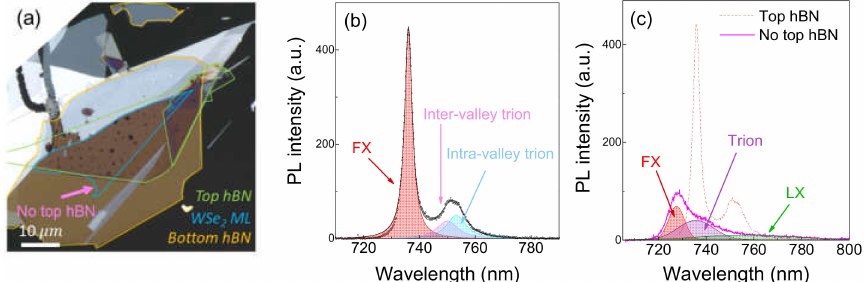
Figure 1. ( a ) Optical microscope image of the WSe 2 monolayer encapsulated by hBN. ( b ) Photoluminescence spectrum of the WSe 2 ML in hBN at 80 K. The trion fine structure (pink and cyan lines) contributes to the asymmetric line shape of trion emission. ( c ) PL spectra of WSe 2 ML with (red dotted line) and without (pink line) capping hBN